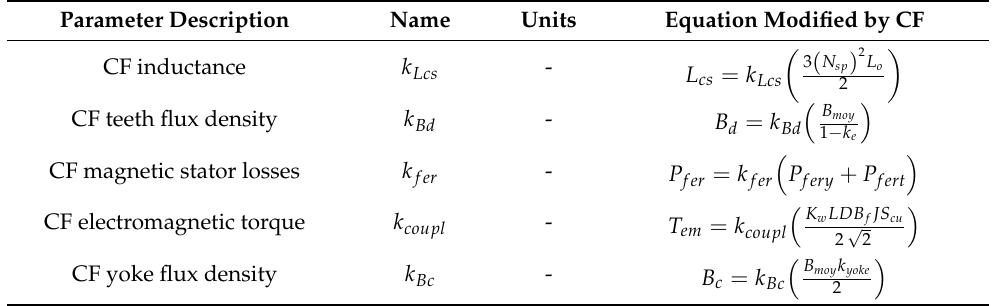
Table 6. Correction factors